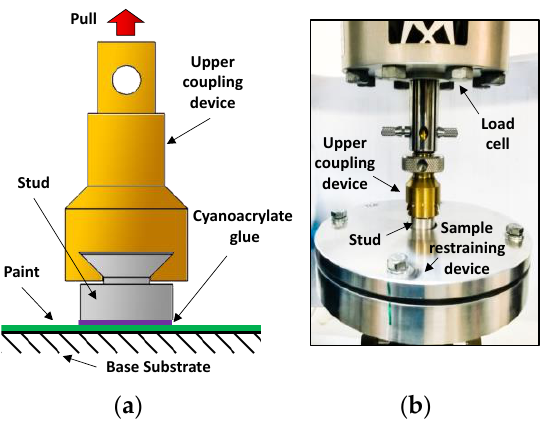
Figure 2 . Sketch ( a ) and picture ( b ) of pull-off setup according to ASTM 5179 . Figure 2. Sketch ( a ) and picture ( b ) of pull-off setup according to ASTM 5179.